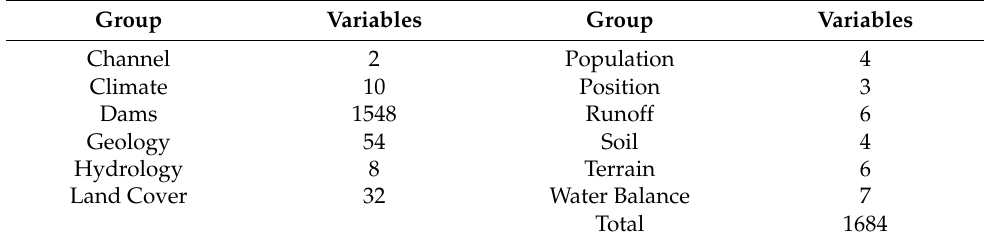
Table 1. The number of variables per factor